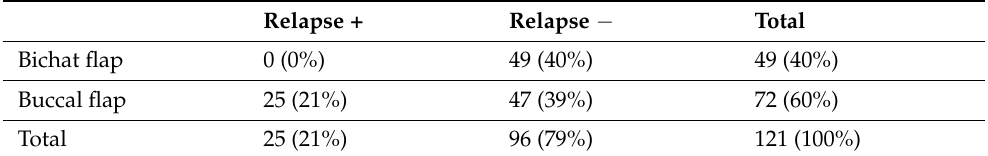
Table 3. Crosstabulation between identified relapses for Bichat fat pad flaps and Buccal advance- ment flaps.